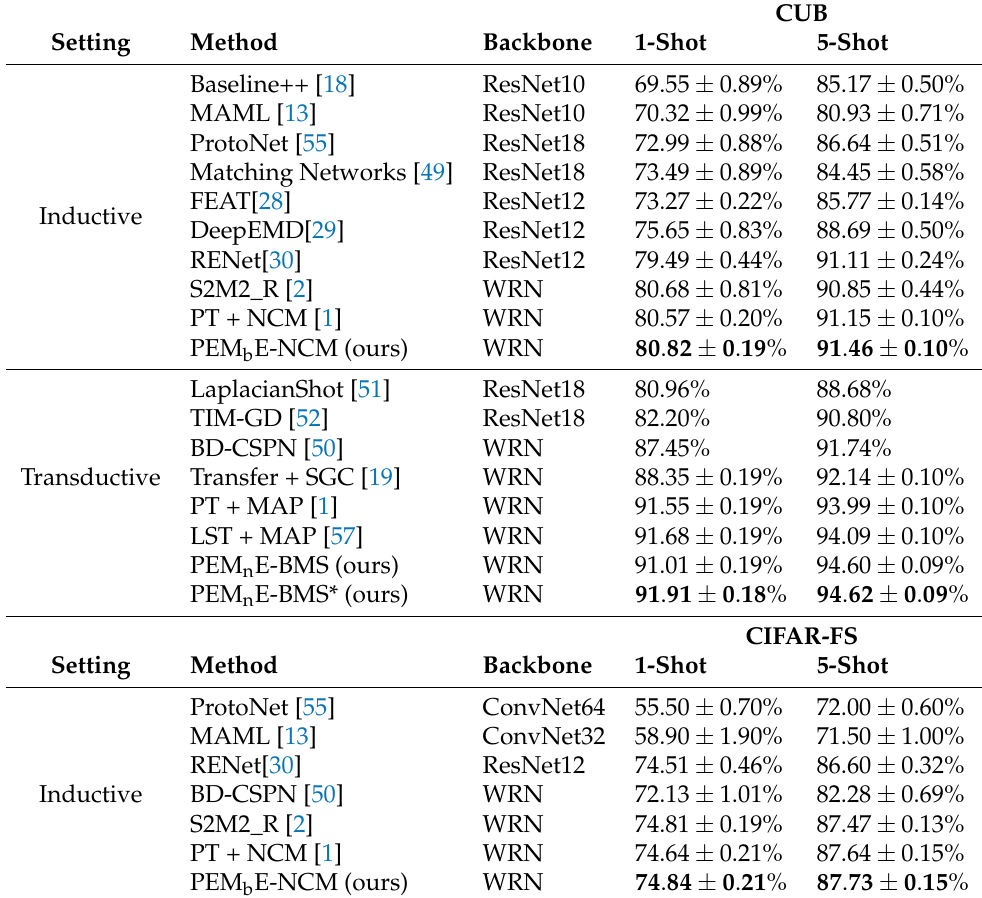
Table 2. The 1-shot and 5-shot accuracy of state-of-the-art methods on CUB and CIFAR-FS. Best results are in